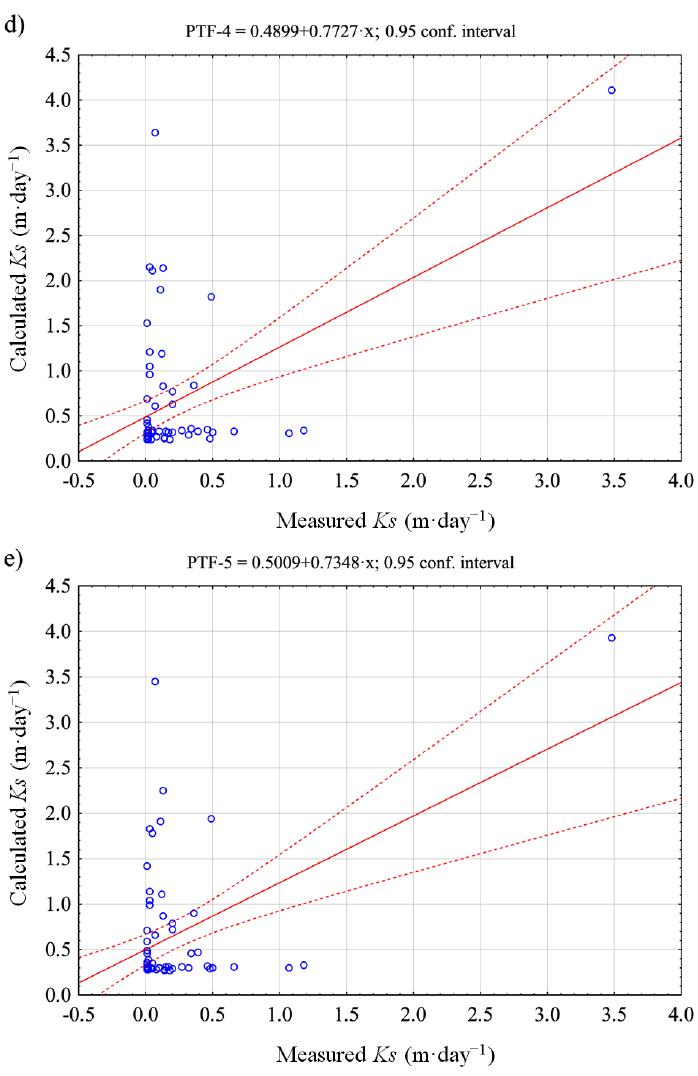
Figure 6. The laboratory measured and predicted saturated hydraulic conductivity Ks for the five pedotransfer function models invistigated